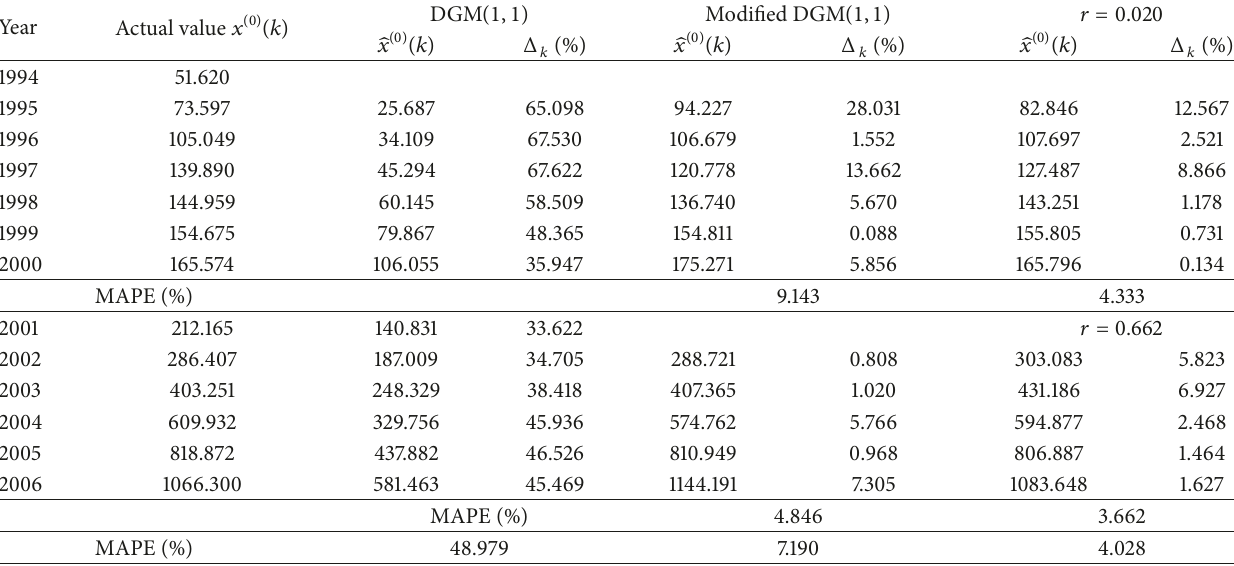
Table 1: The fitted values and MAPE of different discrete grey models (unit: $ billion).